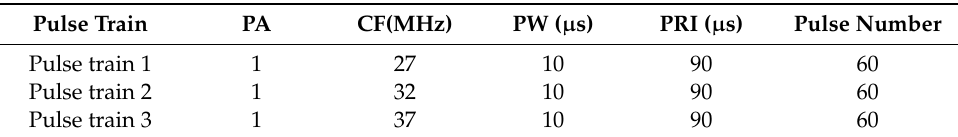
Table 5. Simulation parameters.